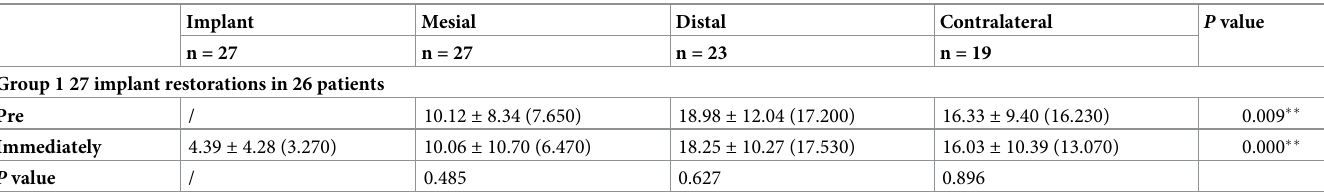
Regardless of unilateral (category 1) or bilateral (category 2) missing teeth, the occlusal force of the posterior segment on the restored side increased significantly ( P = .013,.001, respec- tively) and decreased (though not significantly) in the contralateral posterior segment and